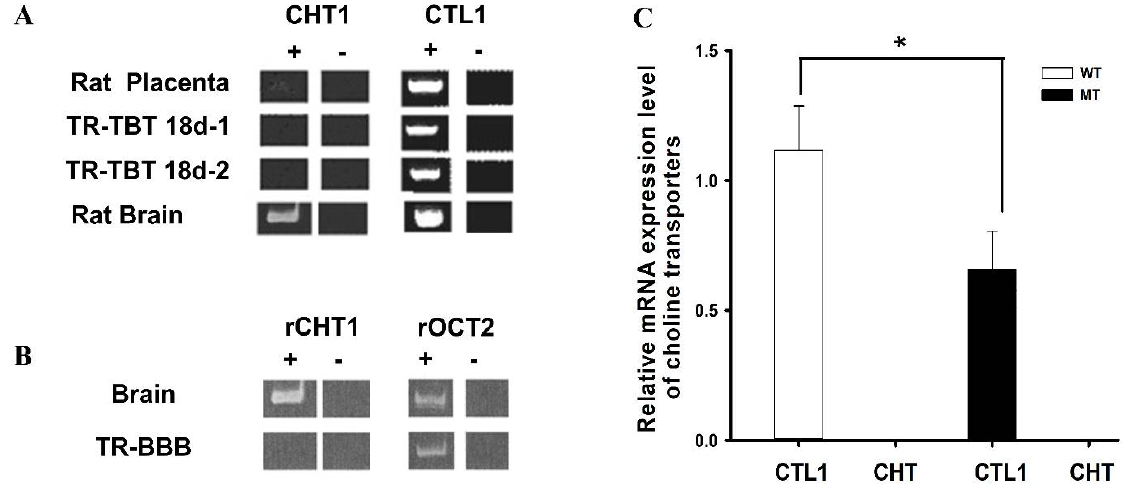
Figure 2. Relative expressions of transporters in ALS model cell lines. The data in ( A ) was retrieved and analyzed from the earlier published study by Lee et al., 2009, in TR-TBT cells [16]. ( B ) Determination of rCHT1 and rOCT2 in TR-BBB cells. This data is retrieved from our previous research by Kang et al., 2005, in TR-BBB cells [106]. ( C ) CTL1 mRNA expres- sion levels were determined using quantitative RT-PCR analysis and normalized to the internal control GAPDH in ALS model cell lines. Each value represents the mean ± SEM. ( n = 3–4). * p < 0.05 indicates a significant difference with respect to the WT